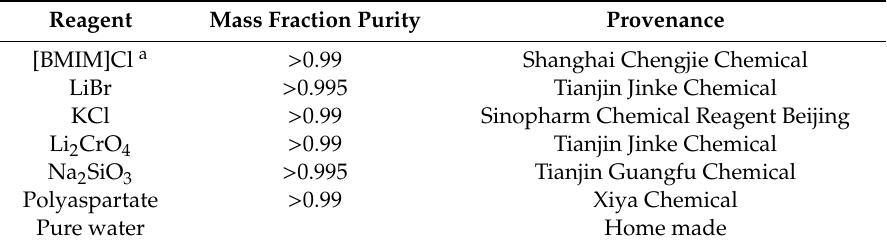
Table 1. Provenance and mass fraction purity of the